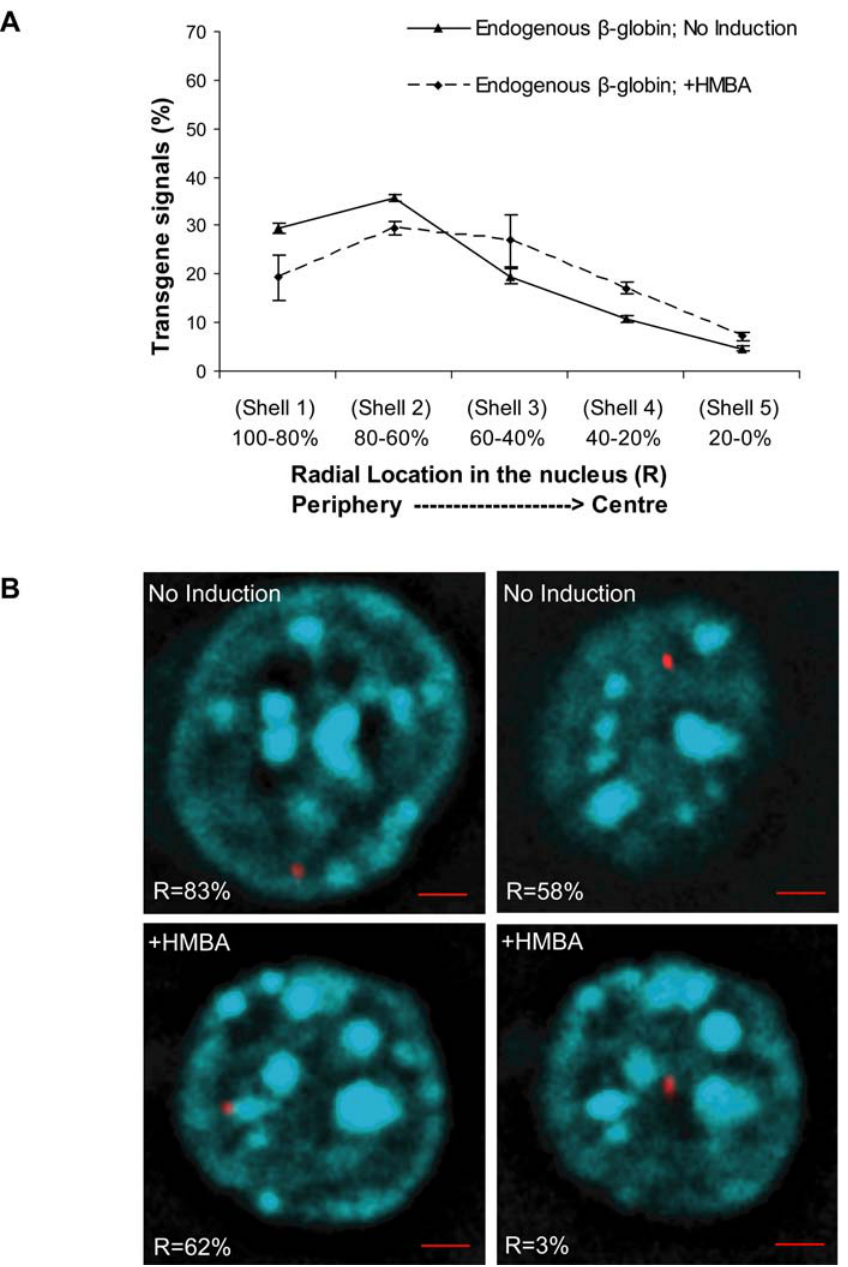
Figure 7. Nuclear relocalization of the endogenous b -globin locus in MEL cells during HMBA induction. (A) Radial distribution of the endogenous mouse b -globin locus examined by 3D DNA FISH as described in Figure 6. Each condition was repeated in three individual experiments with greater than 250 transgene signals scored. (B) Examples of endogenous mouse b -globin locus localization by 3D DNA FISH, with or without HMBA induction. Two z-sections from the same cell containing one FISH signal each are shown and were used for radial measurements. The transgene is detected in red with DIG labeled BAC probe, and nuclear DNA is counterstained with DAPI (cyan). The number at the bottom of each panel represents the radial location in the nucleus shown. Red scale bars indicate 2 m